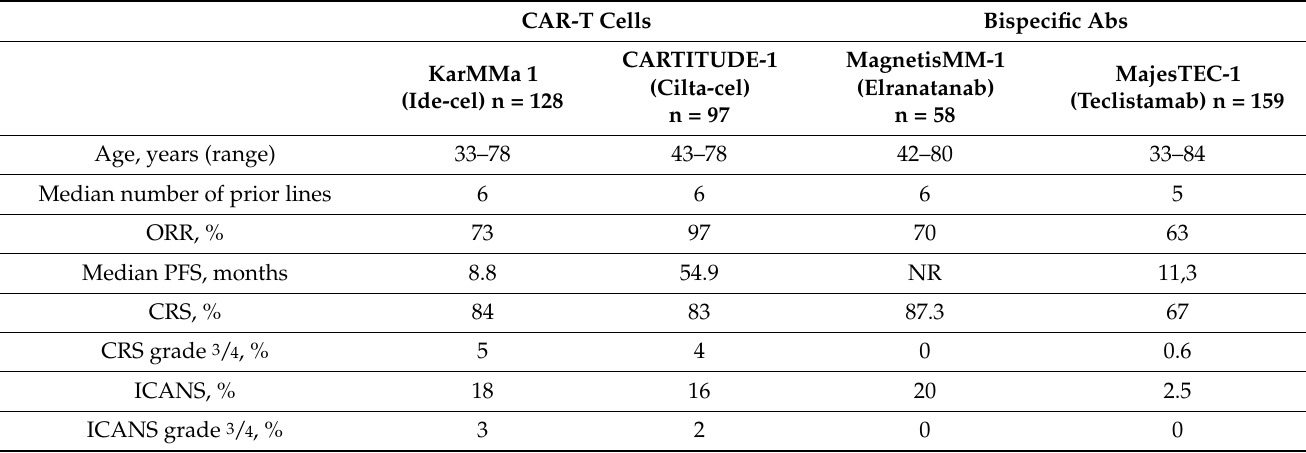
Table 2. Data from pivotal CAR-T cells and bispecific antibodies clinical